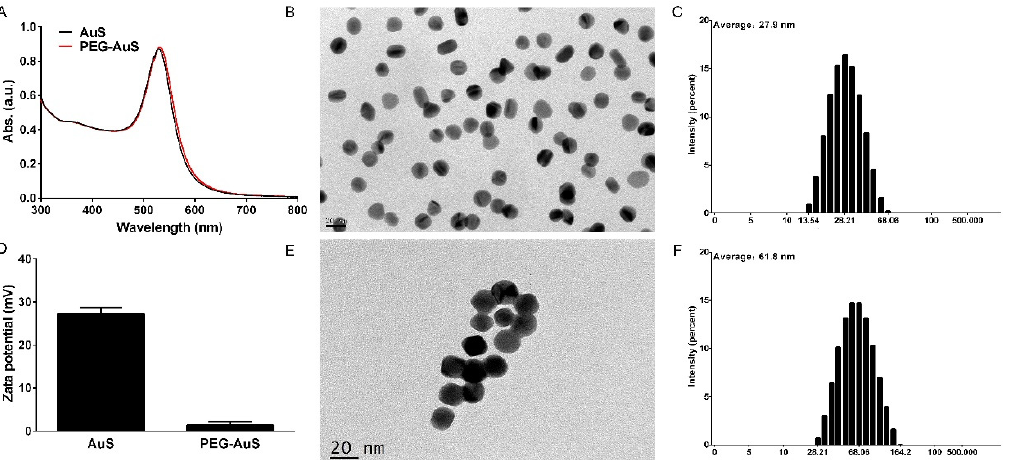
Figure 2. Synthesis and properties of AuS and PEG-AuS. Notes: ( A ) UV-vis absorption spectra of AuS and PEG-AuS. ( B , E ) Transmission electron microscopy images of AuS and PEG-AuS. ( C , F ) Hy- drodynamic size distribution of AuS and PEG-AuS. ( D ) Zeta potential of AuS and PEG-AuS.